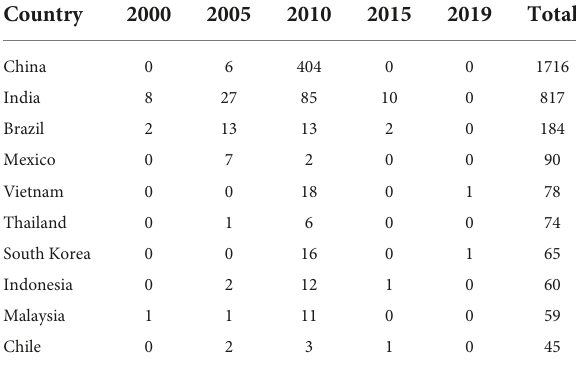
TABLE 2 Top 10 countries’ CDM implementations by